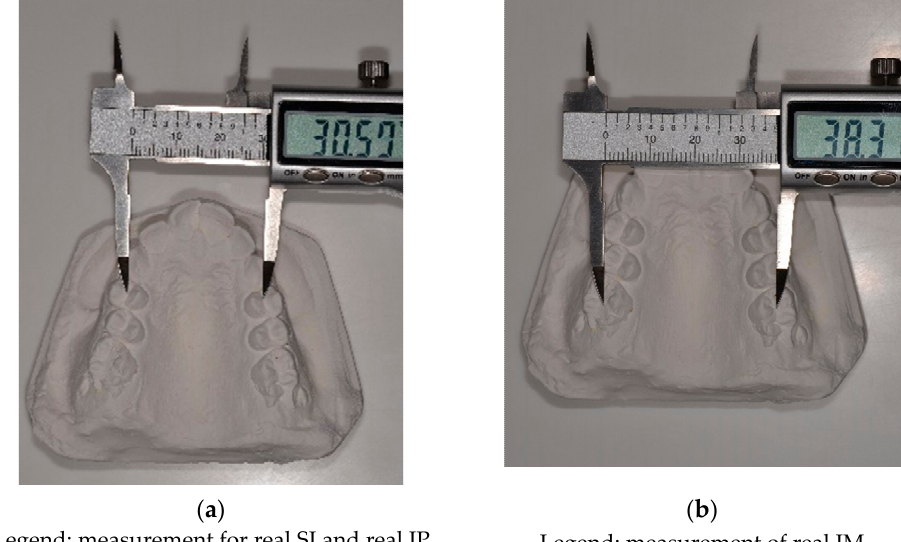
Figure 1. Methods of measuring: ( a ) SI and IP with the digital caliper by placing the beaks in the center of the occlusal groove of the first maxillary premolars; ( b ) IM in the center of the occlusal surface of the first permanent molars.